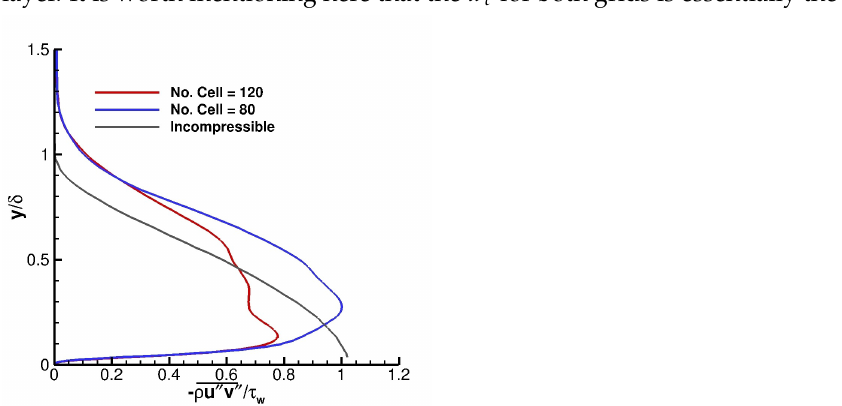
Figure 20. Morkovin scaled dimensionless turbulent shear stress at x / δ = 20 for condition No. 2 and two grids with 80 and 120 cells in wall normal direction inside the boundary layer.